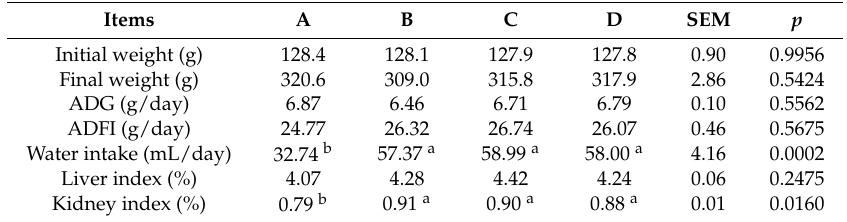
Table 1. Effect of betaine on growth performance of high-salt stressed Sprague–Dawley rats. Items A B